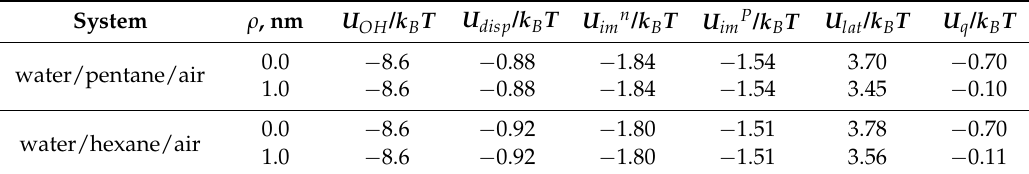
Table 1. Contributions of different types of interactions into the total adsorption potential for water molecules in 1 nm thick alkane